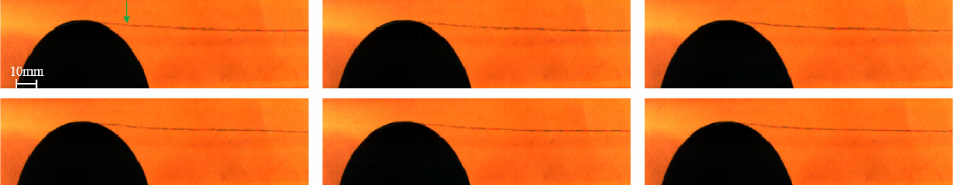
Figure 3. Fully developed inception of tip vortex cavitation NACA 66(2)-415, α = 8 ◦ , σ = 2.14.